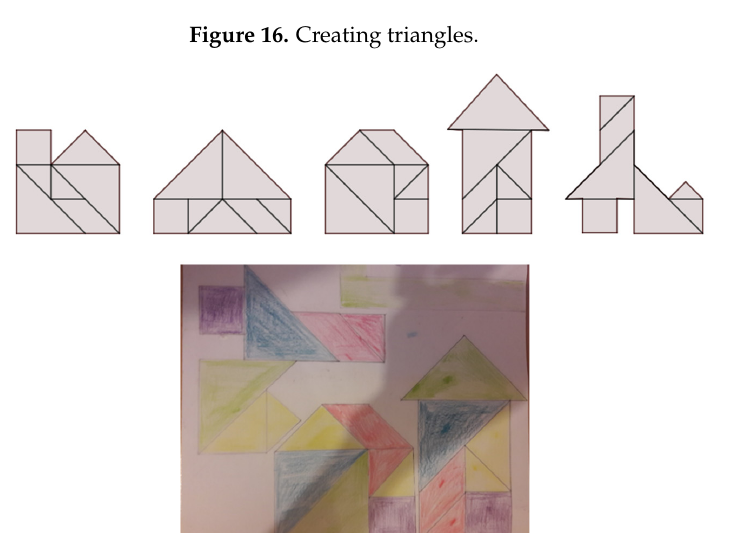
Figure 16. Creating triangles.